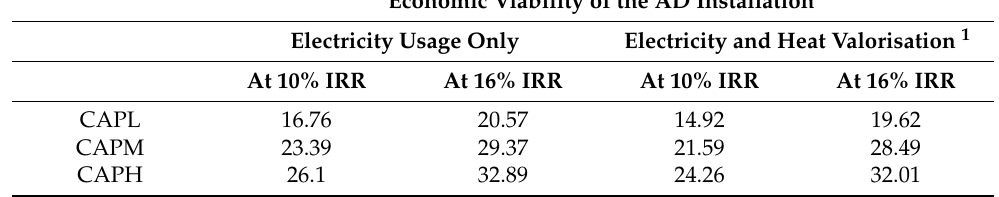
Table 9. Minimum economic electricity prices at varying capex and IRR under a tariff-free regime with 70% heat